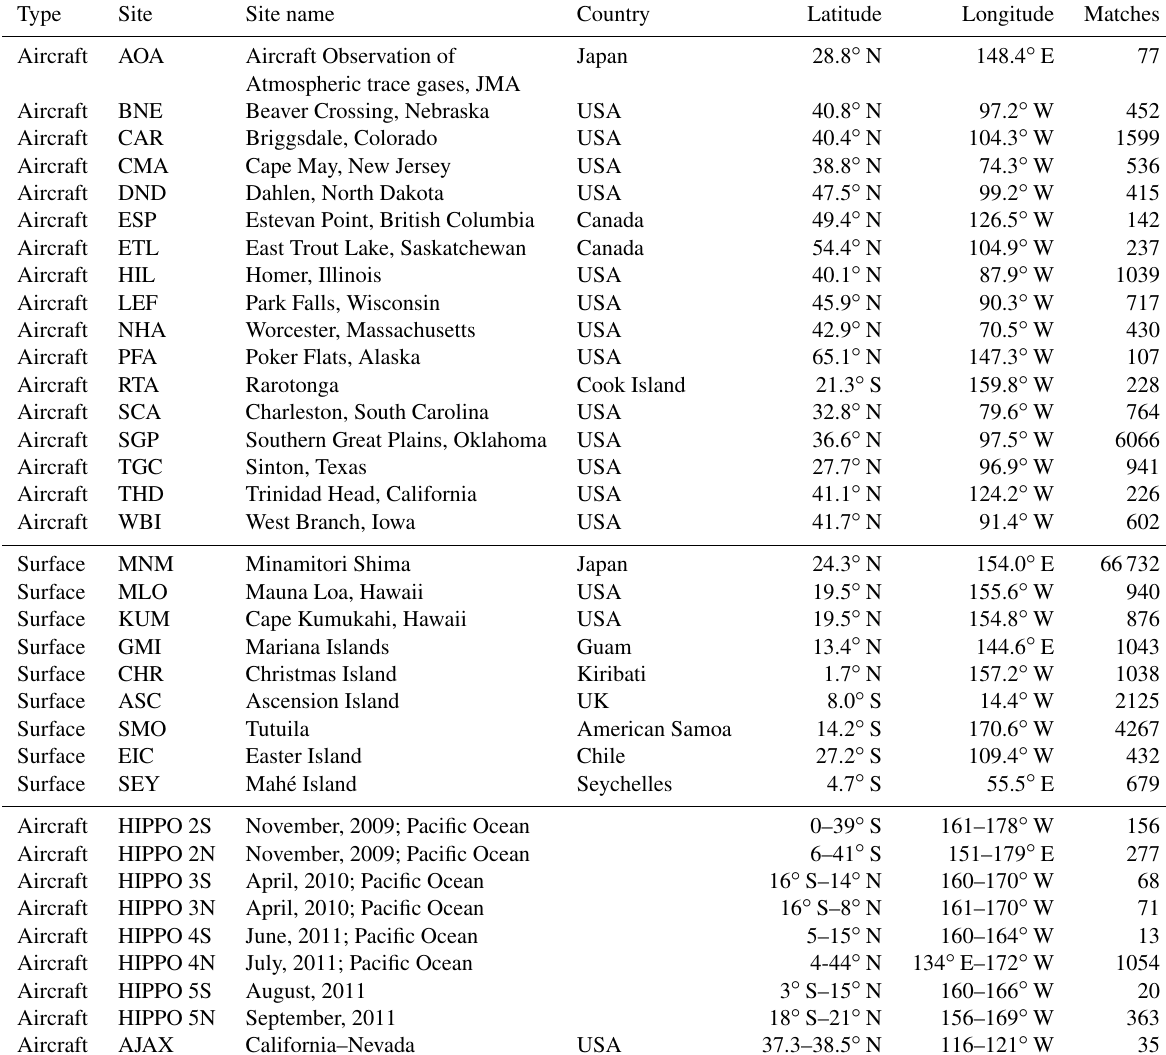
Table 1. Sites used for validation in this